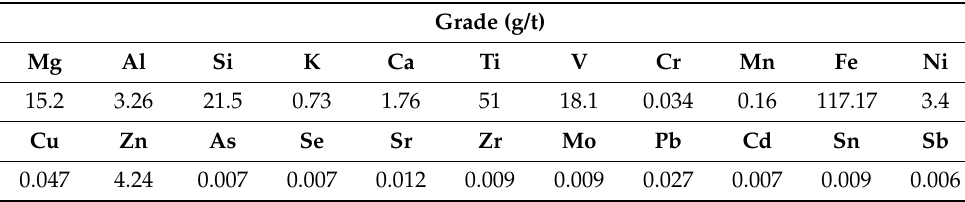
Figure 2. The micrograph of mineral part of heavy oil. Table 1. The results of atomic emission analysis.